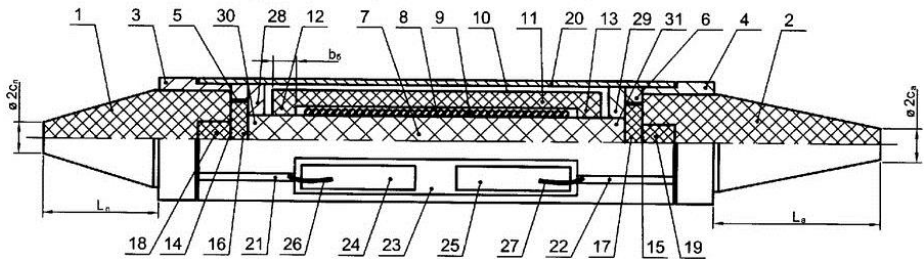
Fig. 1. Schemes and draft of PAA elements: pass ( а ) and reflective (b).